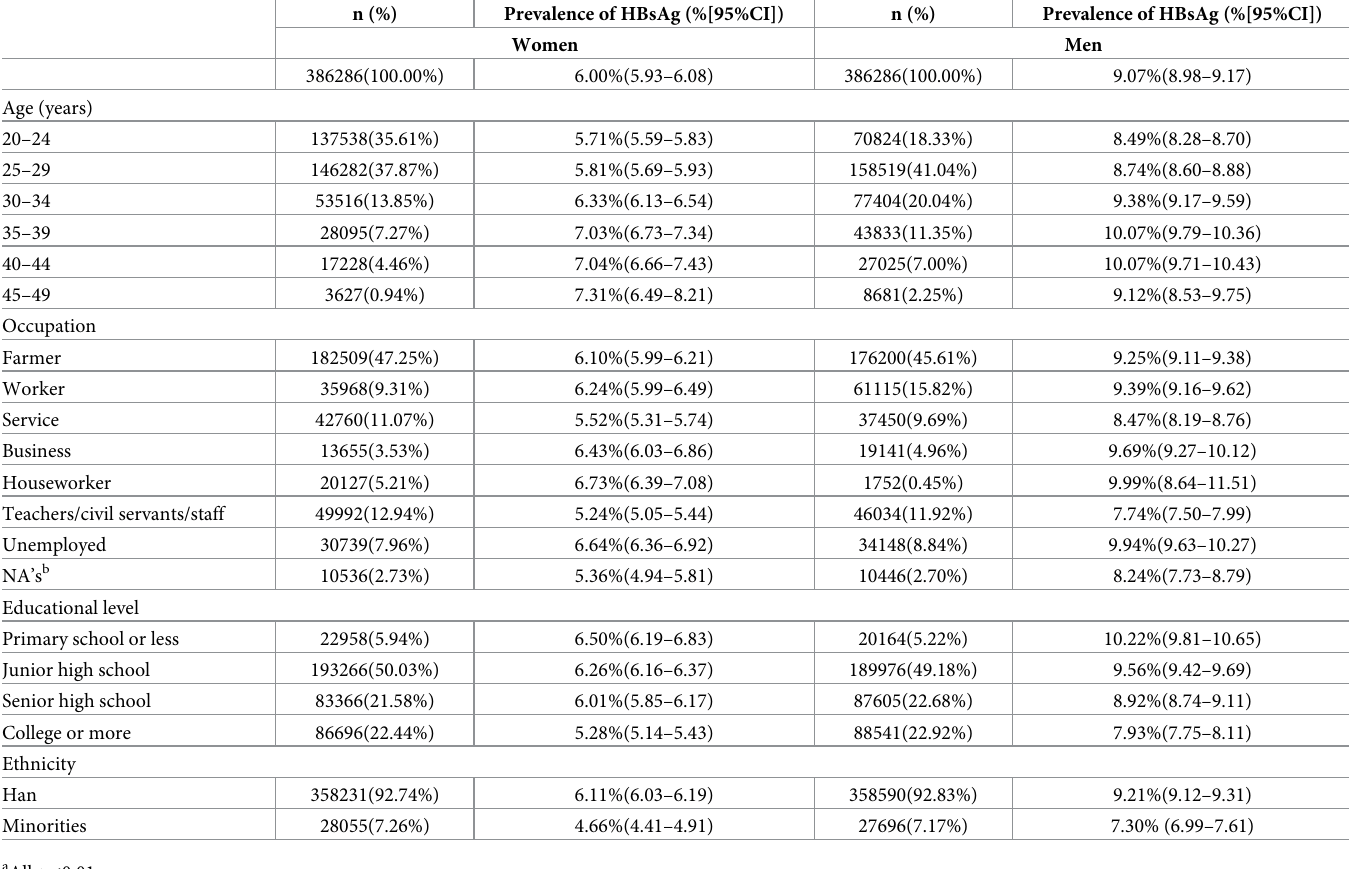
Table 1. Sociodemographic characteristics and prevalence of HBsAg a